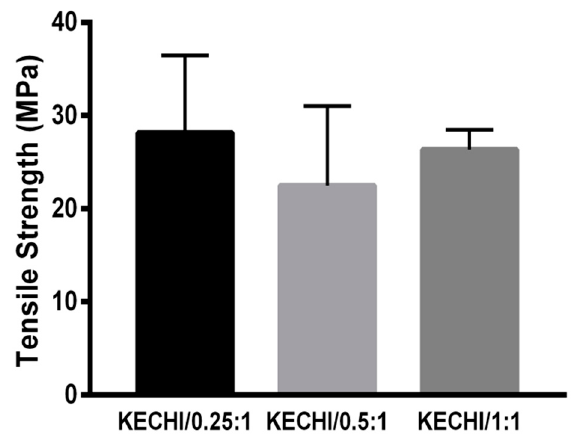
Figure 5. Tensile strength of keratin-chitosan composite membranes.